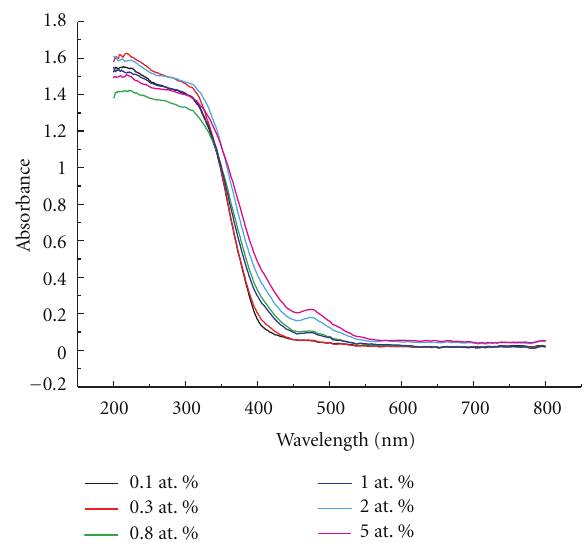
Figure 4: The DRS UV-Vis spectra of Fe-doped TiO 2 nanoparticles.